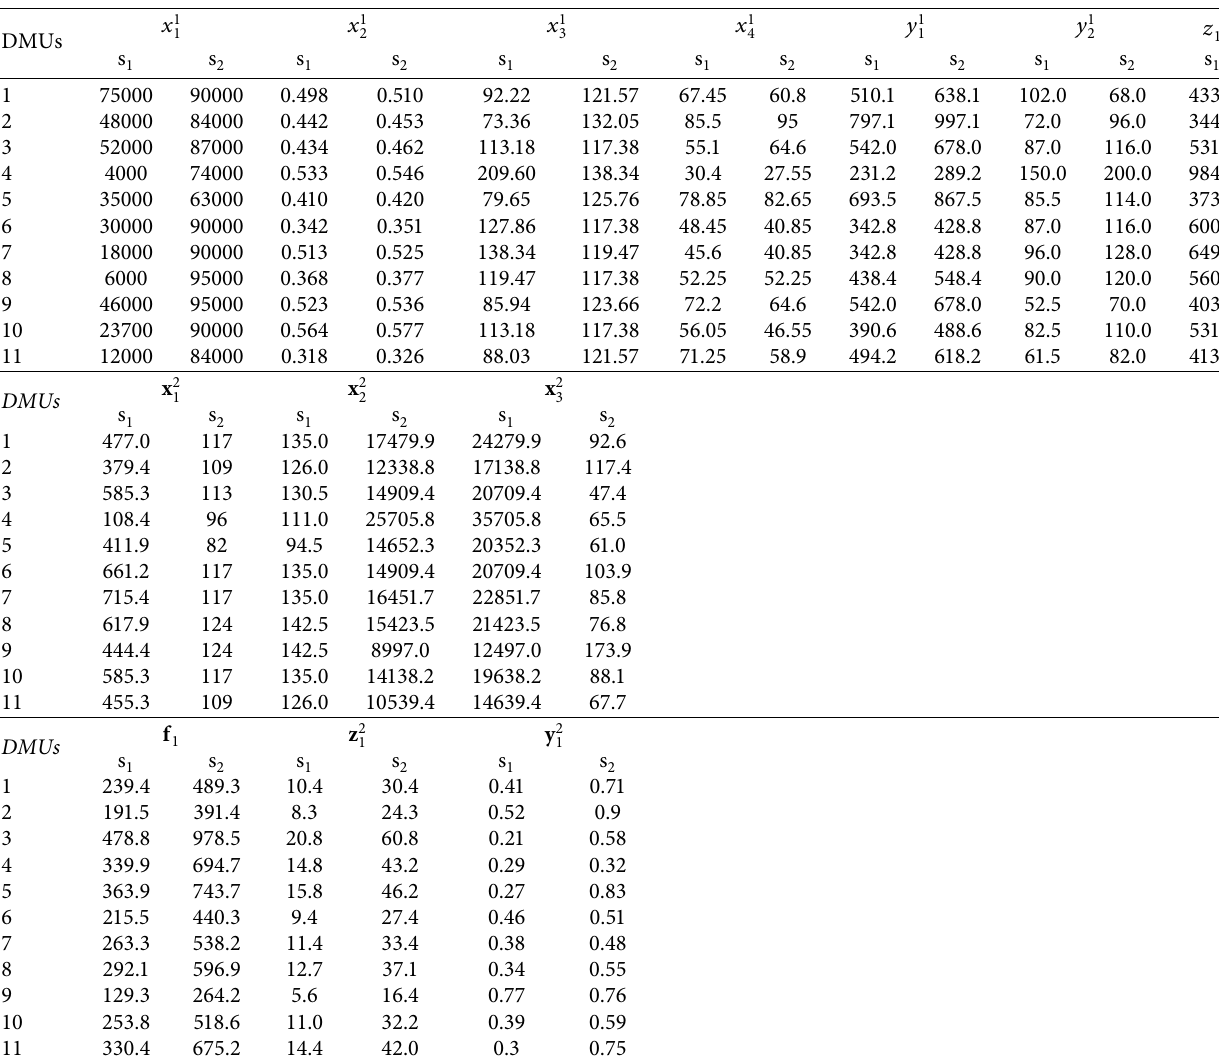
Figure 2: Flowchart of two-stage stochastic p robust. Table 4: The data set of three scenarios for 11